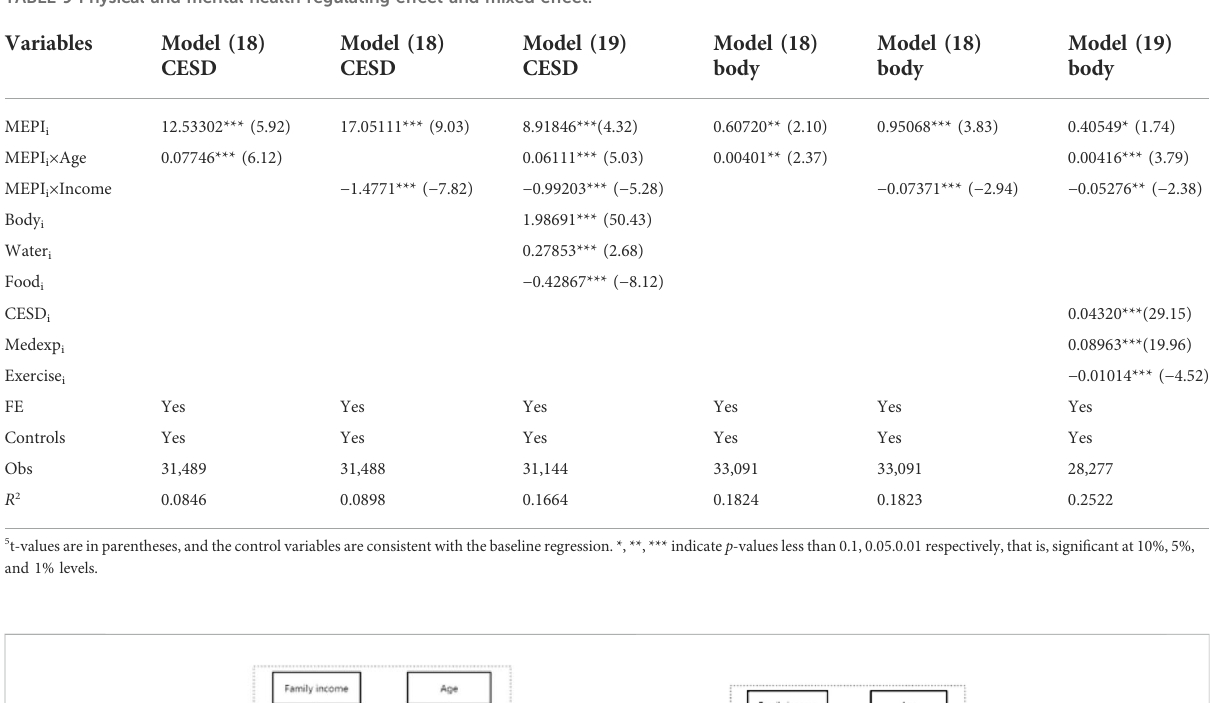
TABLE 9 Physical and mental health regulating effect and mixed effect.